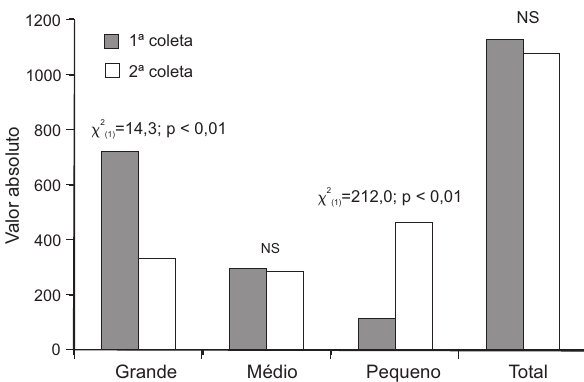
Figura 3. Número de indivíduos pequenos (0,3-4,0 cm de comprimento de concha), médios (4,1-6,0 cm) e grandes